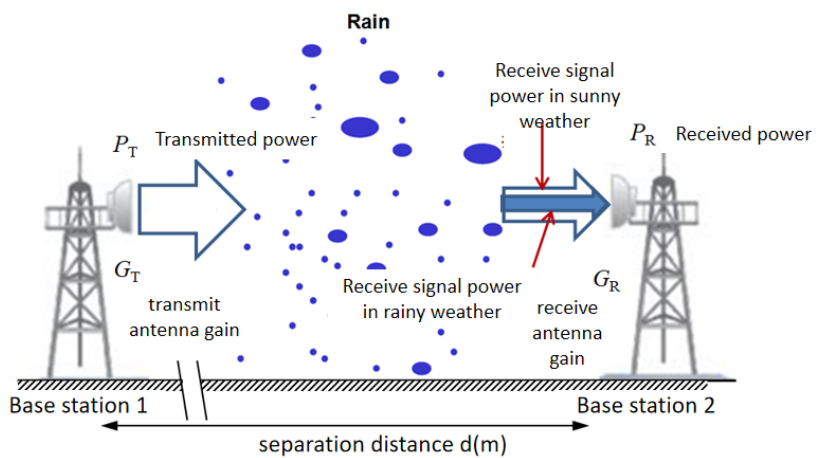
Figure 1. Schematic view of a wireless transmission link from one base station to another during rain and the received signal power is additionally attenuated by A (dB).